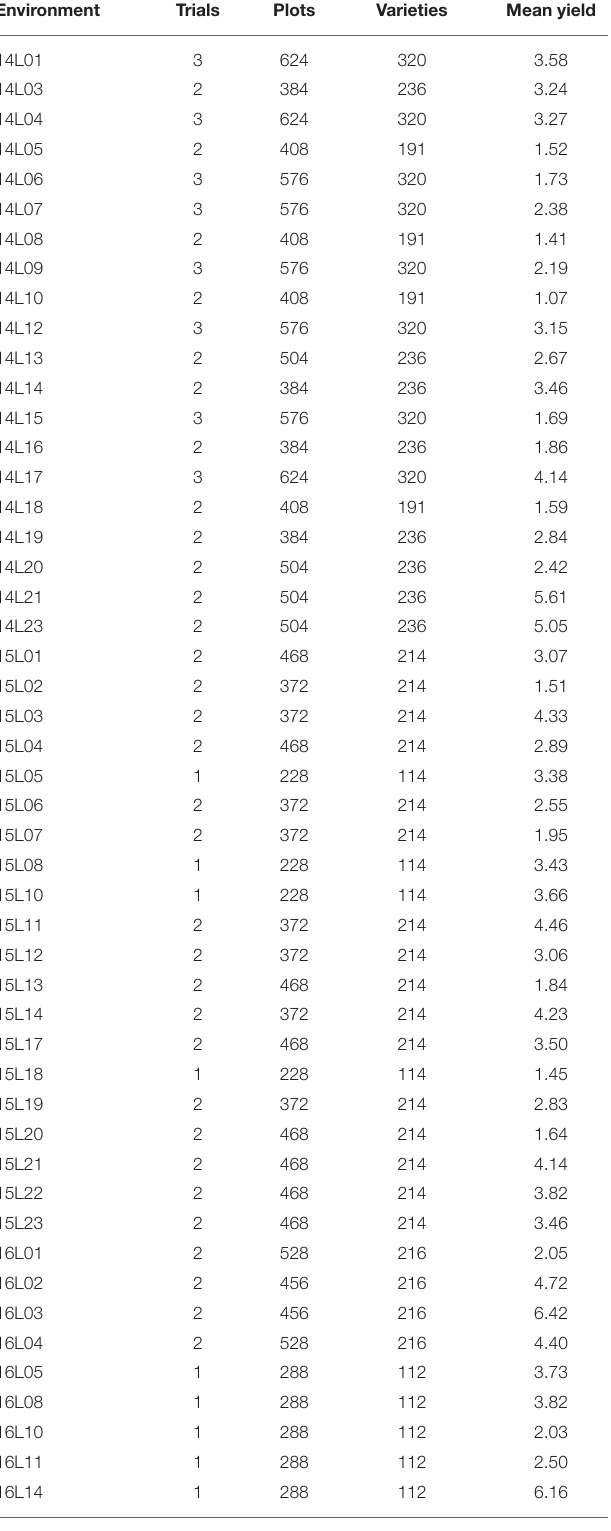
TABLE 1 | Environment summary information: numbers of (co-located) trials, plots, and varieties; mean yield (t/ha). Environment Trials